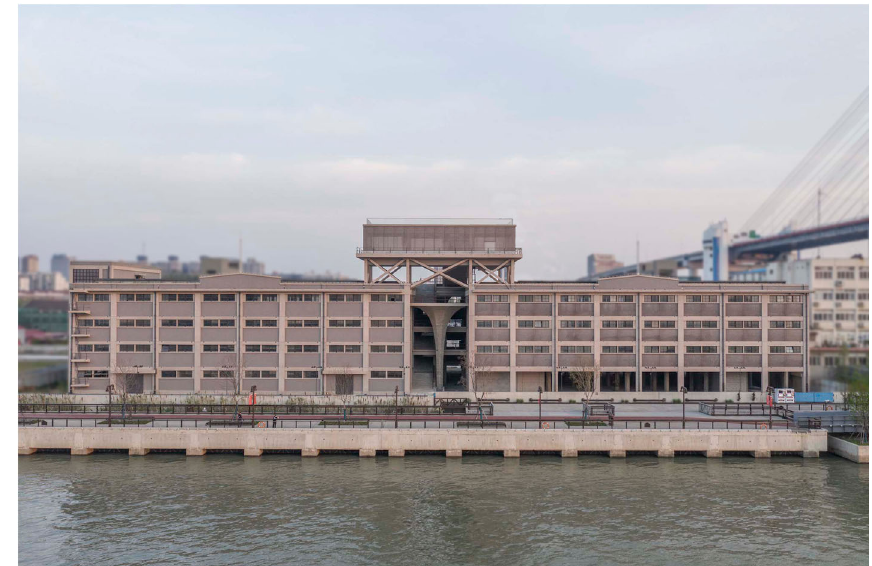
Fig. 1 View from the Yangpu waterfront: Yong ’ an Warehouse (Source: Fangfang Tian)